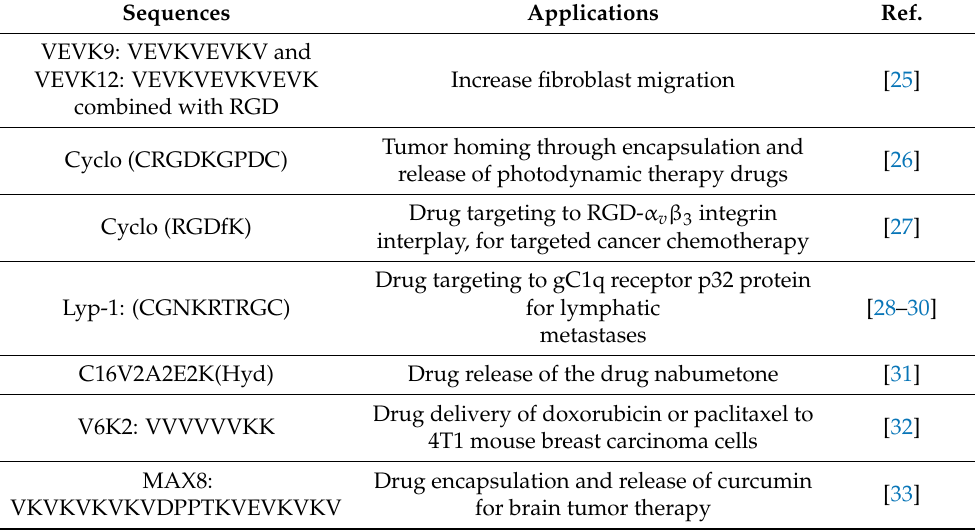
Table 1. List of some self-assembling peptide sequences and recent references (adapted from [18]). Here, the N-protected sequences, with Fmoc, Nap, Bzl, etc., were not reported for the sake of brevity. Sequences Applications